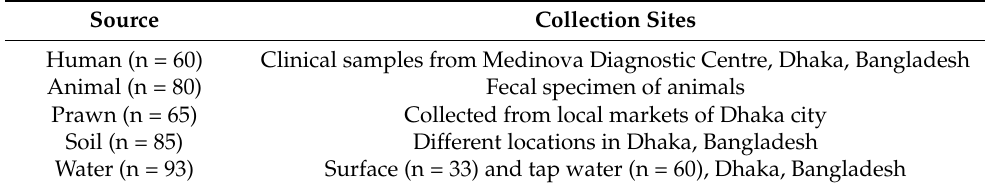
Table 1. Source Distribution of samples collected in this study.